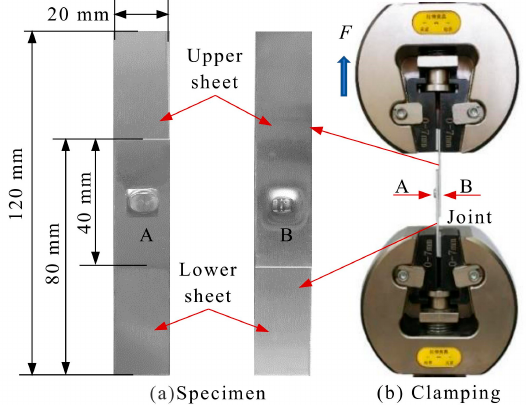
Figure 12. Shearing test on the joint by experiment. ( F is the direction of the loading force, A the joint on the die side and B the joint on the rotated head side).